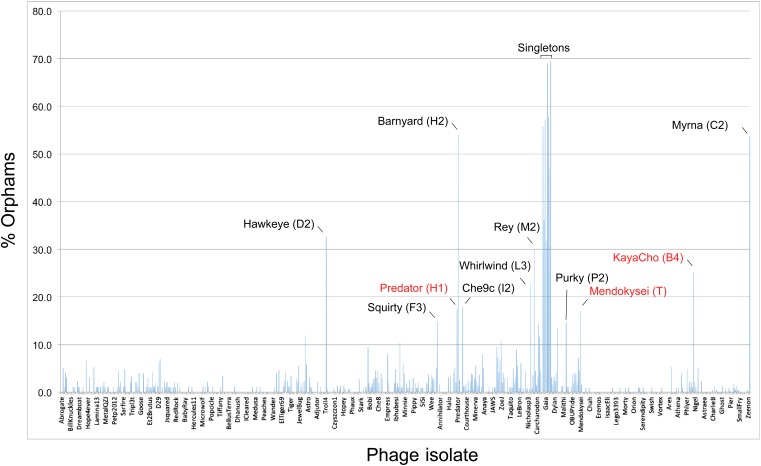
Proportions of orphams in mycobacteriophage genomes.The proportions of genes that are orphams (i.e., single-gene phamilies with no homologues within the mycobacteriophage dataset) are shown for each phage. The order of the phages is as shown in Supplementary file 1. All of the singleton genomes have >30% orphams, and most of the other genomes with relatively high proportions of orphams are the single-genome subclusters (Table 2) including Hawkeye (D2), Myrna (C2), Squirty (F3), Barnyard (H2), Che9c (I2), Whirlwind (L3), Rey (M2), and Purky (P2). Three phages shown in red type are not singletons or single-genome subclusters but have relatively high proportions of orphams. Predator and Mendokysei are members of the diverse and small clusters (five or fewer genomes) H and T, respectively; KayaCho is a member of Subcluster B4 but has a sufficiently high proportion of orphams to arguably warrant formation of a new subcluster, B6.DOI:
http://dx.doi.org/10.7554/eLife.06416.01210.7554/eLife.06416.013Figure 4—source data 1.Pham table containing phamily designations for 627 phage genomes.